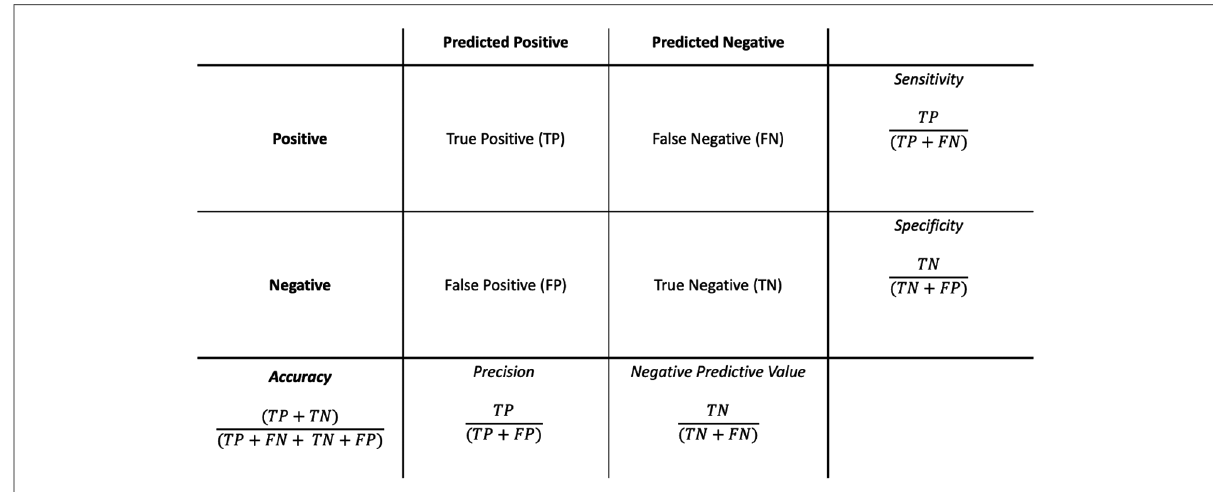
FIGURE 1 Performance metrics calculated from a confusion